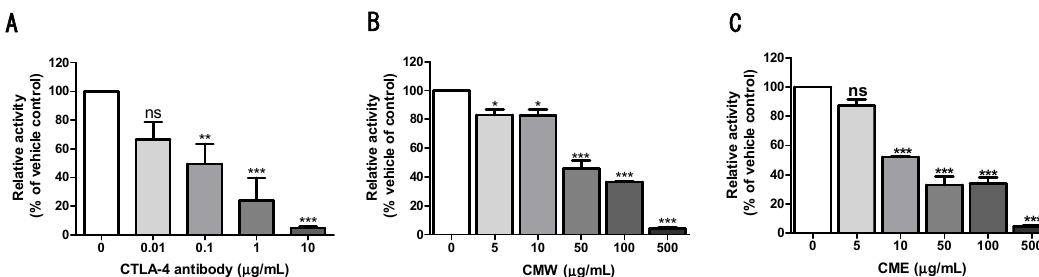
Figure 1. Blocking e ff ect of the CTLA-4 / CD80 interaction of CMW and CME by competitive enzyme-linked immunosorbent assay (ELISA). E ff ect of anti-CTLA-4 neutralizing antibody ( A ); water extract ( B ); and 70% ethanol extract ( C ) of Chaga mushroom on the CTLA-4 / CD80 binding activity. The relative binding activity was normalized to the relative percentage of the vehicle control group. The half-maximal inhibitory concentration (IC 50 ) was calculated using the Prism “log[inhibitor] vs. the normalized response” equation. All results are presented as the mean of three independent biological replicates, with * p < 0.05, ** p < 0.01, *** p < 0.001, compared with the vehicle control group.